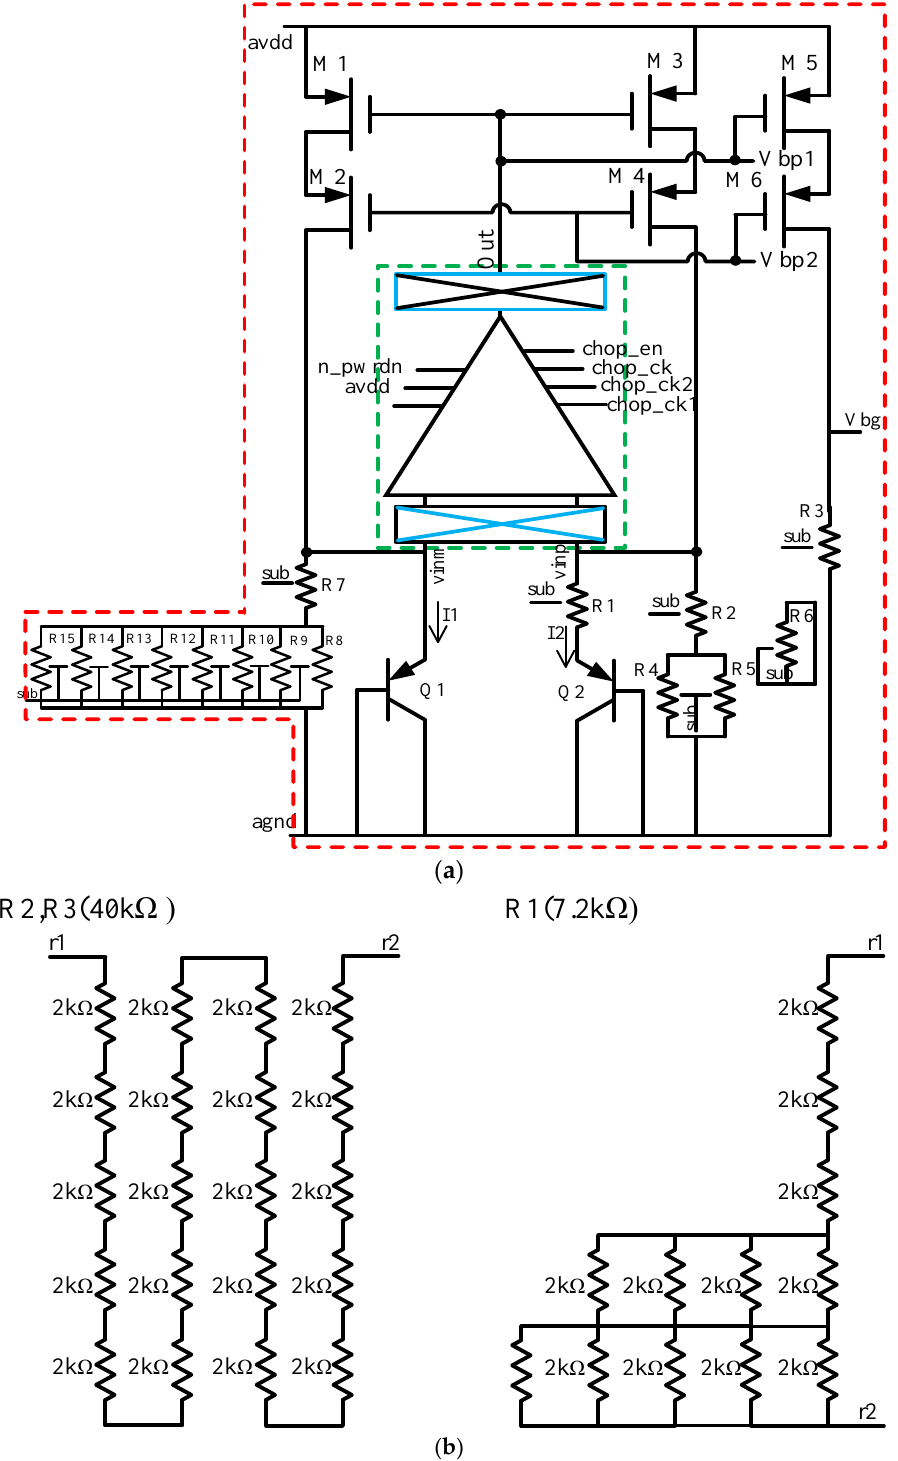
Figure 3. ( a ) Bandgap reference circuit with an embedded chopper circuit; ( b ) implementation of highly matched resistors for the BGR scheme.